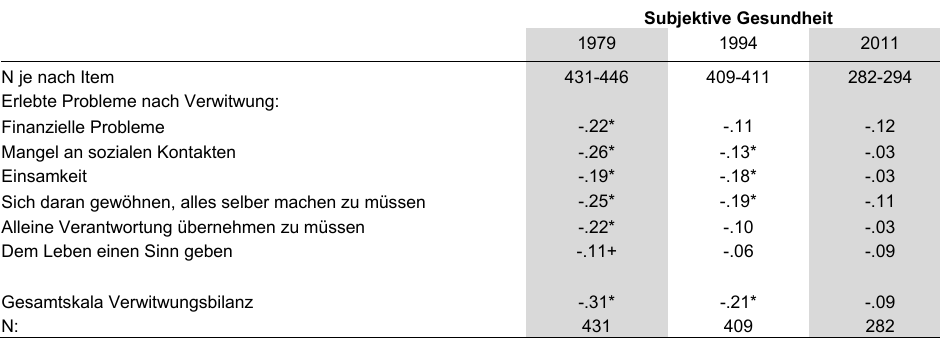
Tabelle 5: Zusammenhang zwischen angeführte Probleme nach Verwitwung und subjektiver Gesundheit im Zeitvergleich